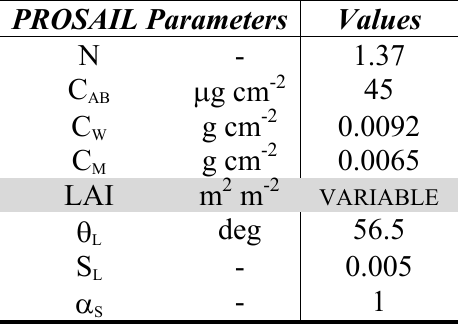
), Leaf Area Index M ), the background L